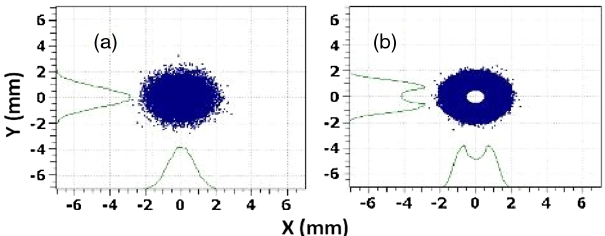
FIG. 2. Input electron distribution to FEL oscillator: (a) Gaus- sian;